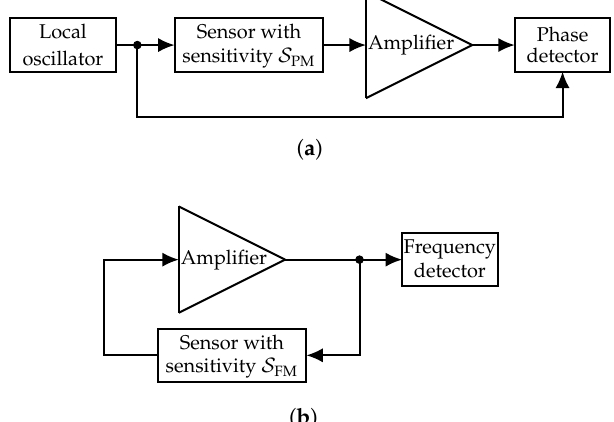
Figure 1. Basic structures of open-loop ( a ) and closed-loop ( b ) sensor readout systems. In open-loop systems, the signal transceived by the sensor is phase-modulated with a sensitivity S PM , whereas the oscillating signal in closed-loop operation is frequency-modulated with a sensitivity S FM . ( a ) Open-loop readout system; ( b ) closed-loop readout